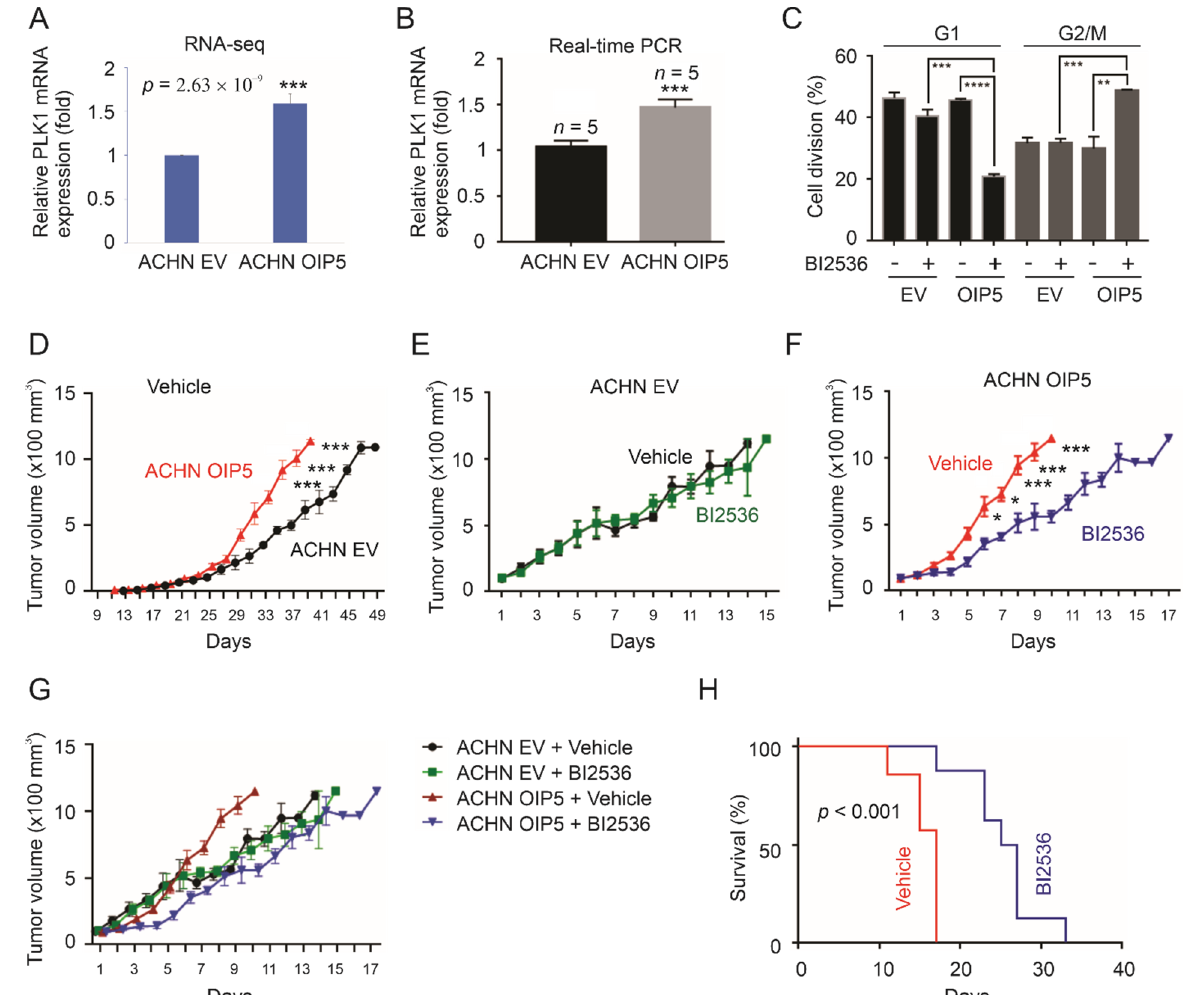
Figure 9. PLK1 inhibitor reduces OIP5-mediated pRCC tumorigenesis. ( A , B ) RNA-seq and real-time PCR analyses of PLK1 expression in ACHN EV and ACHN OIP5 tumors. RNA-seq was performed in 3 each from ACHN EV and ACHN OIP5 tumors. ( C ) ACHN EV and ACHN OIP5 cells were treated with DMSO ( − ) or the PLK1 inhibitor (BI2536) in 40 nM PLK1 inhibitor for 72 h, followed by quantification of cell cycle distributions. Experiments were repeated 3 times; means ± SEMs are graphed. **: p < 0.01, ***: p < 0.001, ****: p < 0.0001 in the indicated comparisons by 2-tailed Student’s test. ( D – G ) Mice bearing ACHN EV or ACHN OIP5 tumors were treated with vehicle or BI2536 (50 mg/kg) intravenously. The overall profiles of tumor growth in the vehicle treated setting ( D ); tumor volumes were recorded following treatments ( E – G ). Statistical analyses were performed using 2-tailed Student’s t -test; *: p < 0.05, ***: p < 0.001. ( H ) Kaplan Meier curve for the indicated mice reaching endpoints. Statistical analysis was performed using logrank test.